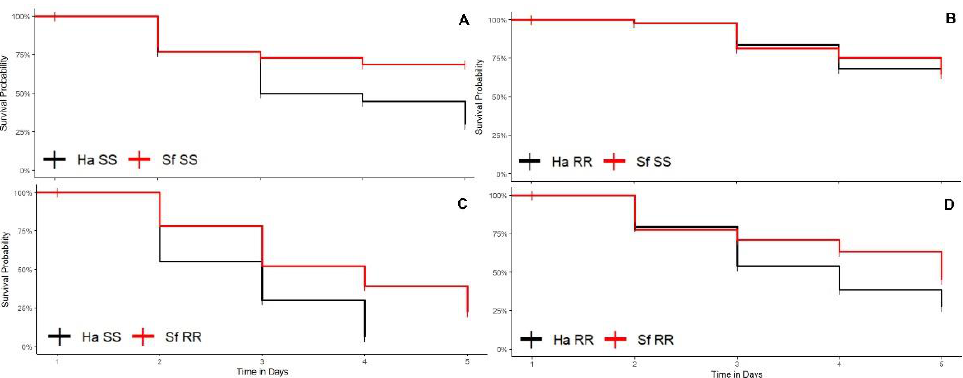
Figure 3. Larval survival curves of strains susceptible (SS) and resistant (RR) to insecticides of Heli- coverpa armigera (Ha) and Spodoptera frugiperda (Sf) maintained in competition in cotton plants. ( A ) Ha-SS versus Sf-SS interaction; ( B ) Ha-RR versus Sf-SS interaction; ( C ) Ha-SS interaction with Sf-RR and ( D ) Ha-RR interaction with Sf-RR.